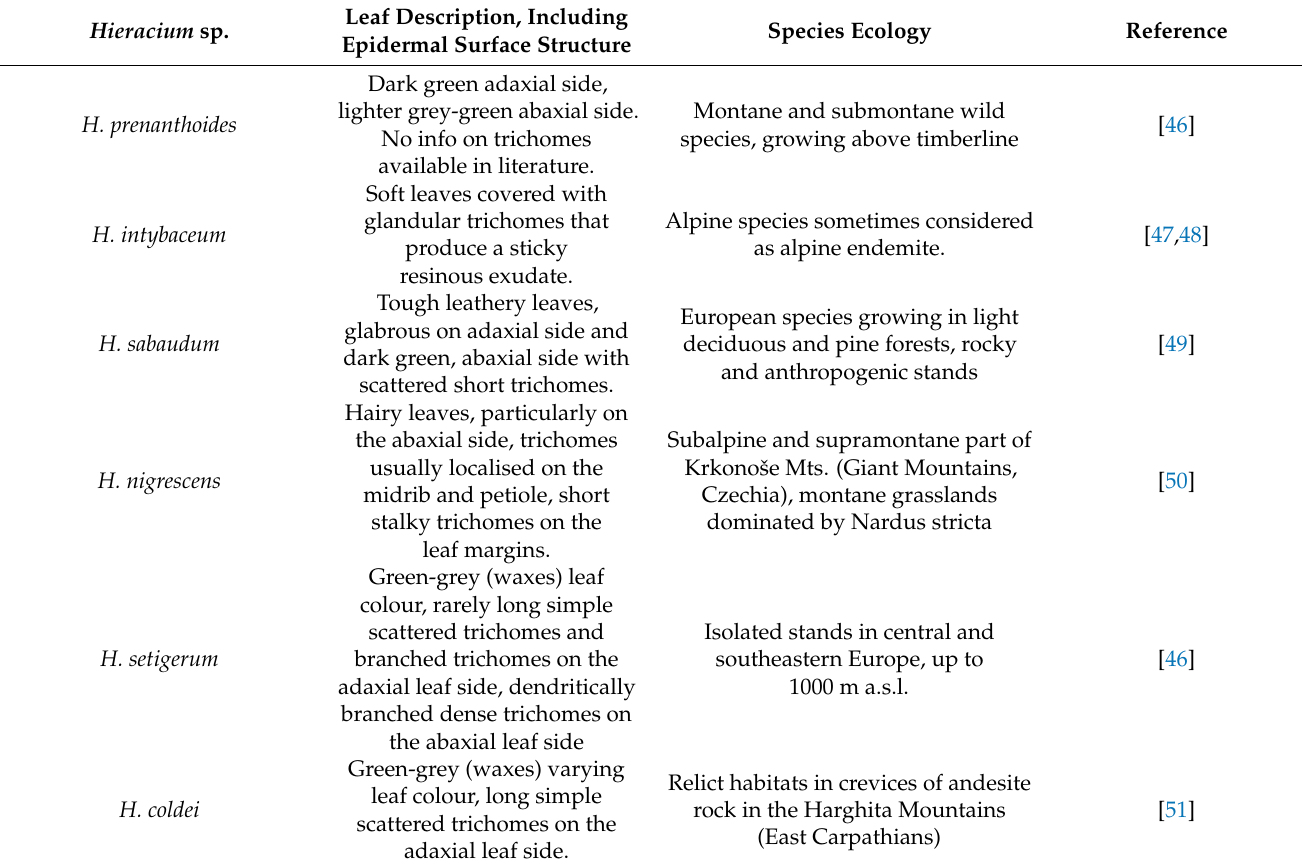
Table 2. Leaf description including epidermal surface structure, ecology of six Hieracium species from a referenced study. Hieracium